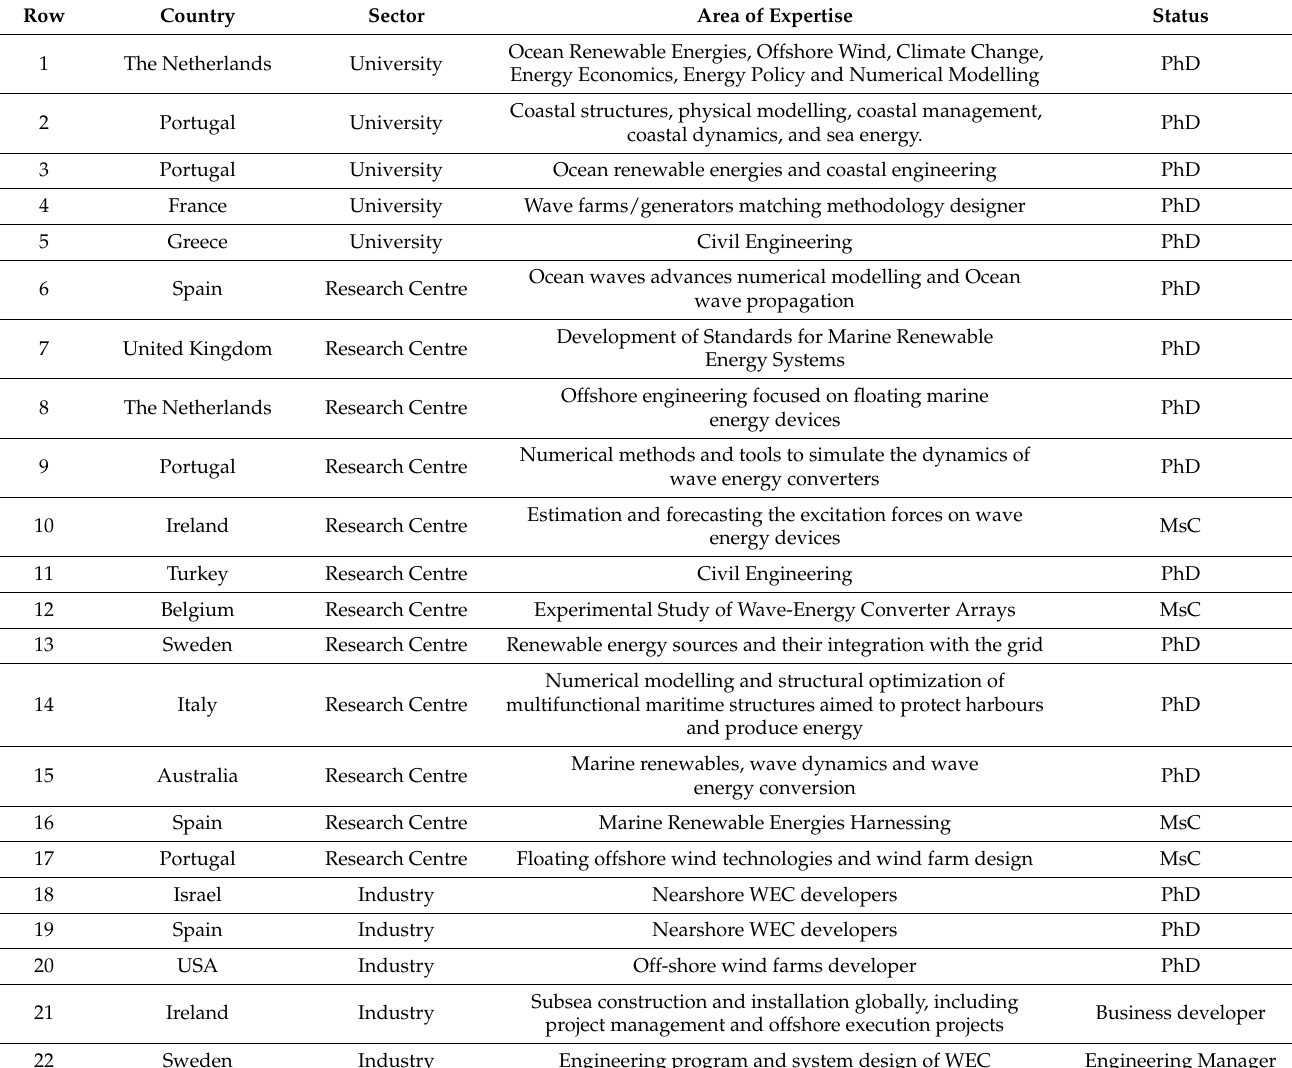
Table A1. Detailed description of the experts participated in the